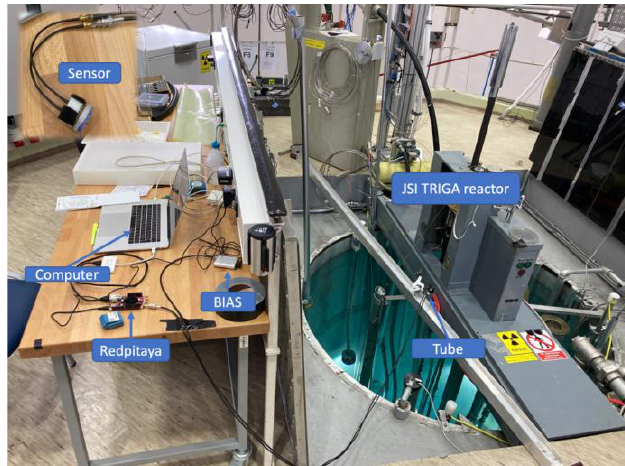
Fig. 8. Photograph of the Cherenkov light measurement setup on the JSI TRIGA reactor platform.